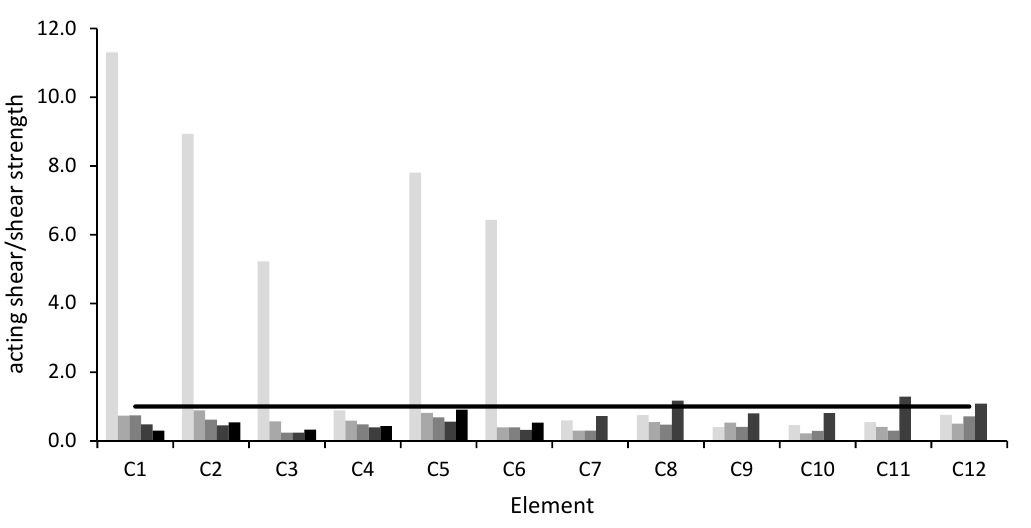
Figure 6. Shear verifications of beams in as-built condition.